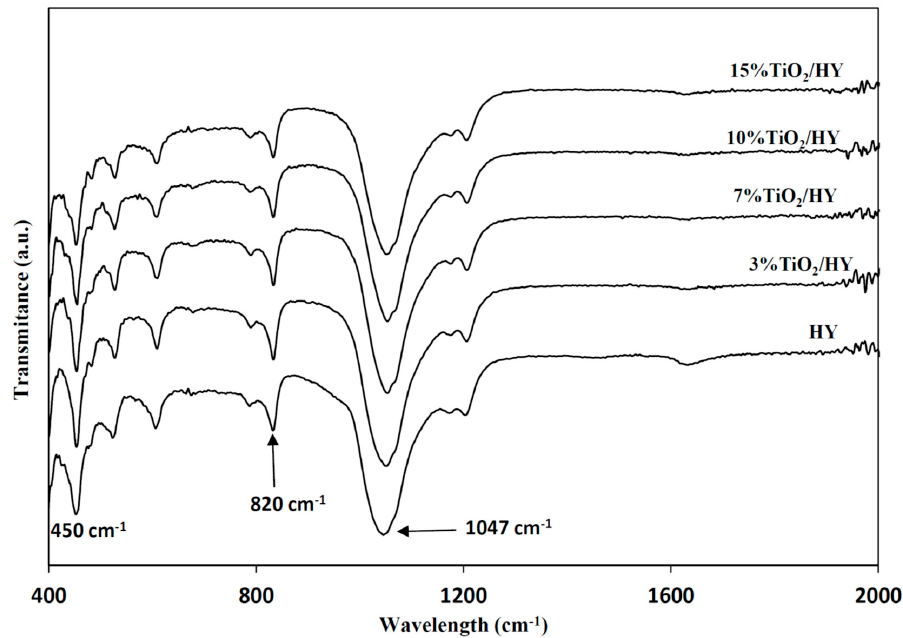
Figure 3. FTIR spectra of HY, 3, 7, 10, and 15 wt% TiO 2 /HY from bottom to top, respectively.